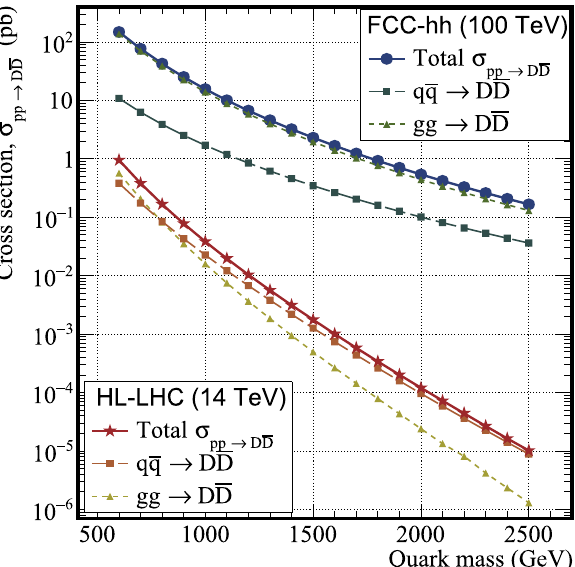
Fig. 1 Tree level Feynman Diagrams for the process pp → D ¯ D directly on events without the need for compilation. CutLang